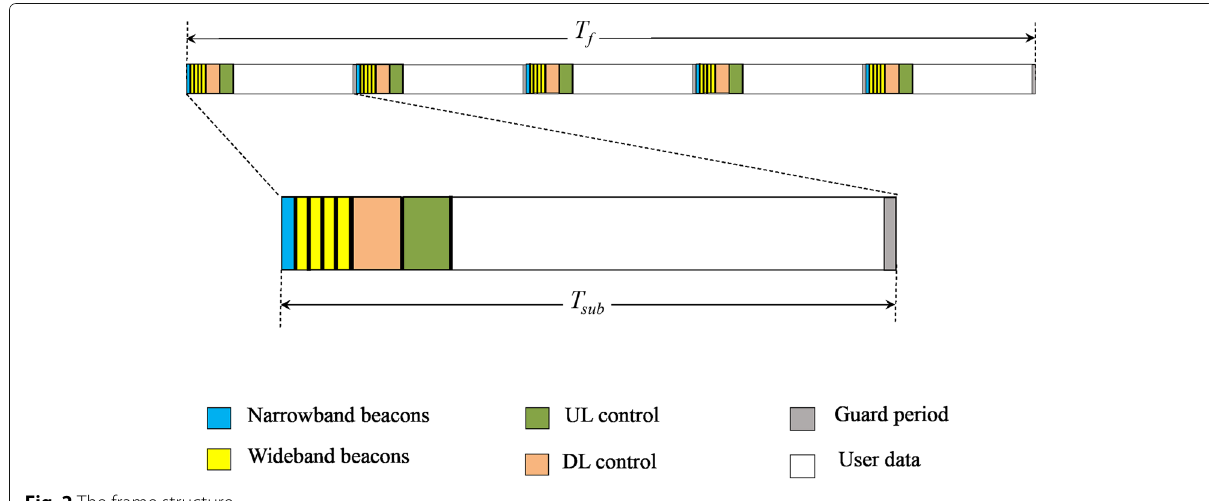
Fig. 2 The frame structure